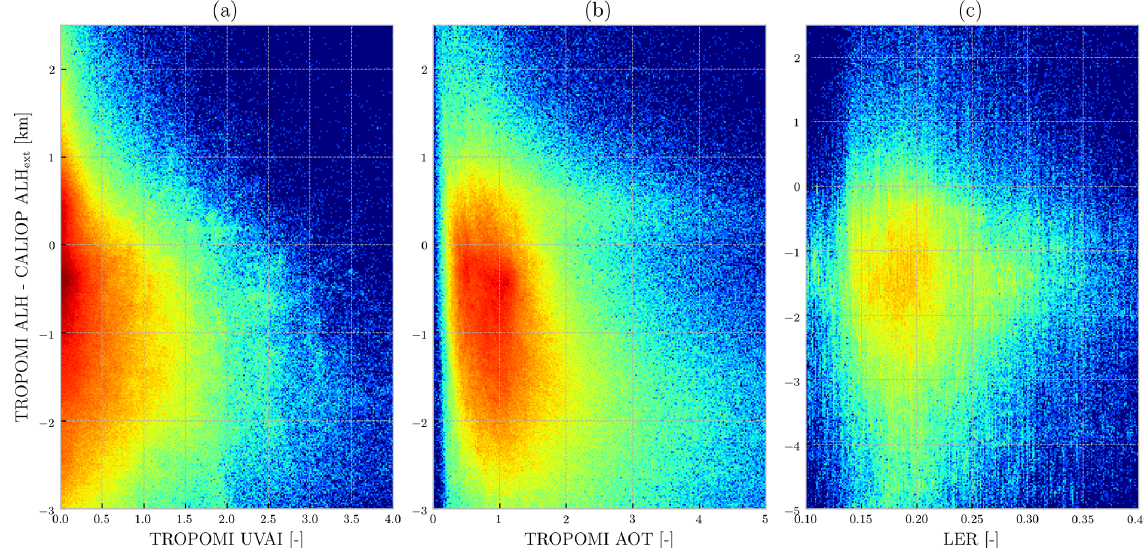
Figure 4. Scatter density plots of the difference between TROPOMI ALH and CALIOP ALH ext as a function of (a) TROPOMI UVAI, (b) TROPOMI AOT and (c) GOME-2 LER for the oxygen A-band used for the TROPOMI retrievals for cases over land (with a minimum surface albedo of 0.1). The colours represent density of plots. The y axis is optimised for each plot. The data are filtered in the same fashion as in Fig. 2, with data over the ocean and land combined for plots (a) and (b) and data only over land for plot (c)